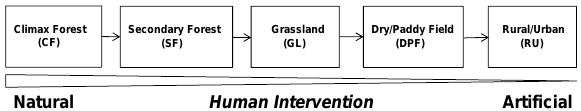
Figure 11. Typical Landscape Transformation Sere (LTS) model (after Hara et